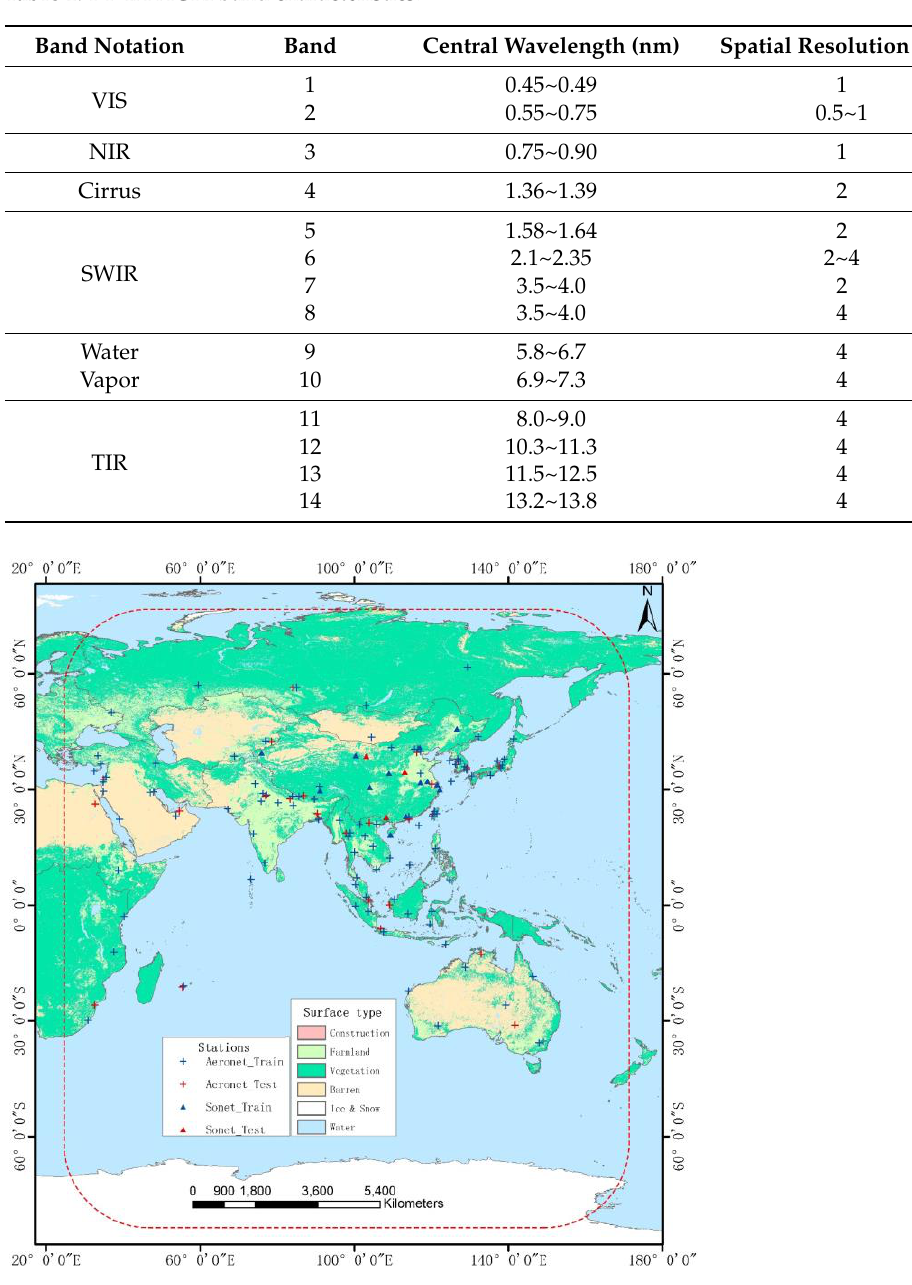
Figure 1. Map showing the area covered by the FY-4A/AGRI full disk (red box: 24°E – 174°E and 80°N – 80°S), with surface type indicated in color as shown in the legend. Additionally shown are the locations of the AERONET sites (crosses), 123 in total, and the SONET sites (triangles), 16 in total. Blue symbols indicate the sites used for training the neural network, 111 in total, and red symbols indicate the validation sites, 28 in total. The station locations include most surface type areas. Surface type data are obtained from the Food and Agriculture Organization of the United Nations (FAO) (https://data.apps.fao.org/map/catalog/srv/eng/catalog.search#/home, last access 7 June